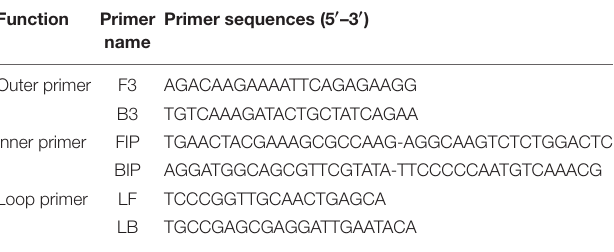
TABLE 1 | Nucleotide sequences of the LAMP caf1 A primers.